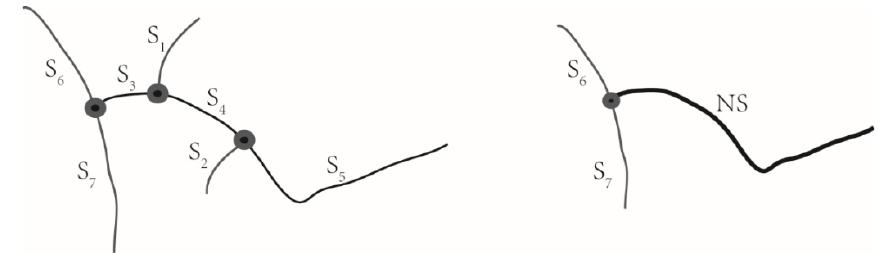
Figure 4. Influence of merging on topological relationships.